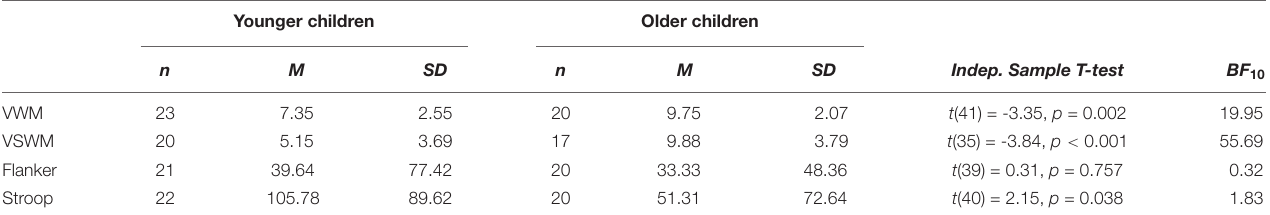
TABLE 2 | Executive functions scores per age